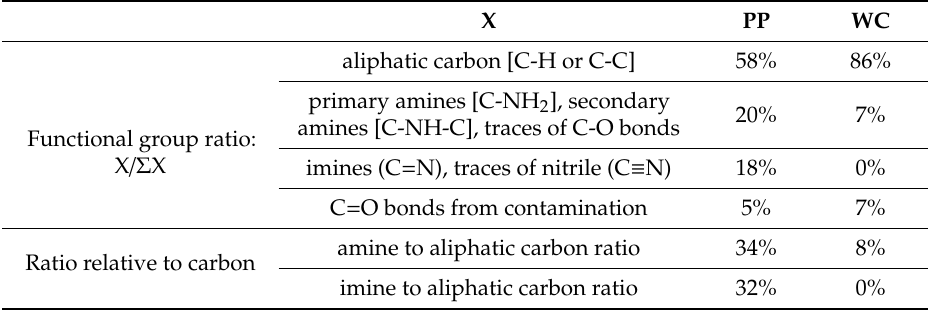
Figure 2. C1s band deconvolution of the PP ( a ) and WC ( b ) coatings. Table 1. Ratio of functional groups of the PP and WC coatings with-out gold incubation as analyzed from C1s peak. All the XPS data was plotted with a standard error of